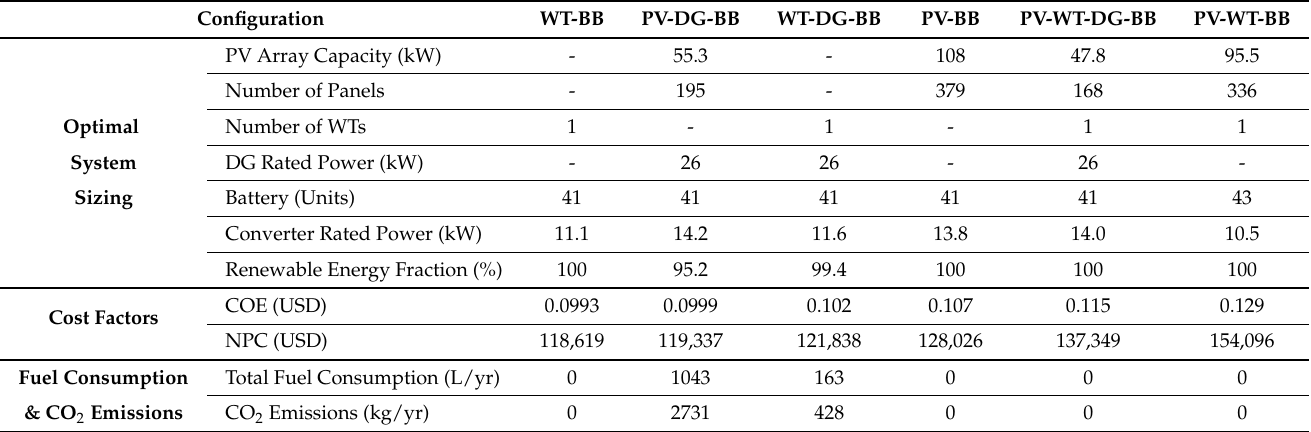
Table 12. Simulation Results for Jal-Alayah Cell Site—Case